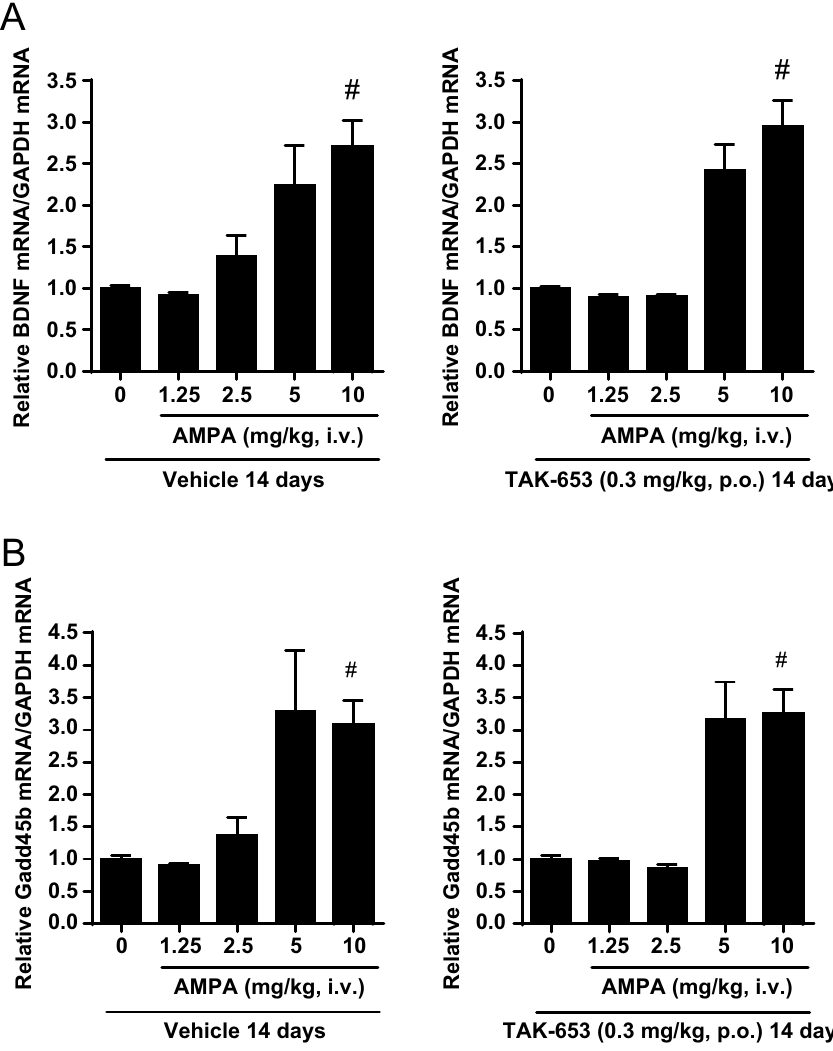
Figure 5. Effects of repeated treatment of TAK-653 on AMPA-induced BDNF ( A ) or Gadd45b ( B ) mRNA expression in mouse hippocampus. Vehicle or TAK-653 (0.3 mg/kg, p.o.) for 14 days were administered to mice. On the day 14, vehicle or AMPA (1.25, 2.5, 5 or 10 mg/kg, i.v.) was administered 1 h after vehicle (left) or TAK-653 (right). Tissues were isolated 3 h after AMPA administration. Data were presented as the mean ± SEM (n = 23–24). # P ≤ 0.05 (versus vehicle-treated group; two-tailed Shirley–Williams